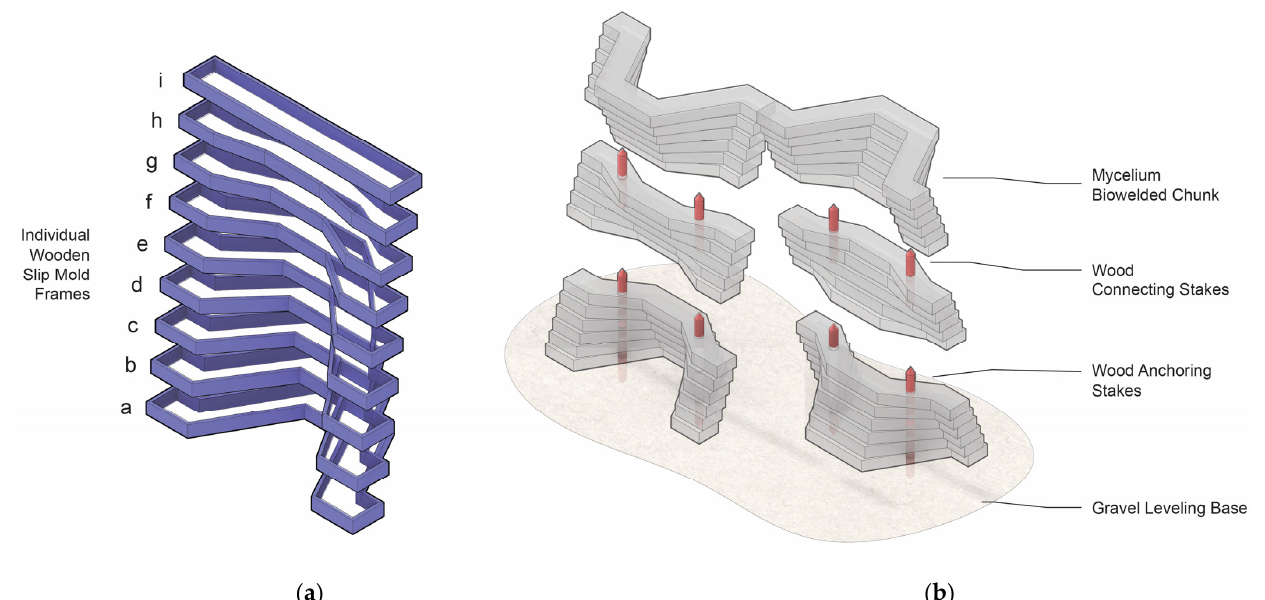
Figure 7. Design diagrams for La Parete Fungina. ( a ) Diagram of the nine different wooden slip-form frames (a–i) designed for growing slabs; ( b ) axonometric assembly diagram of the unit chunks highlighting the friction-based connection system of the wooden stakes. Drawings by Emmett Lockridge.